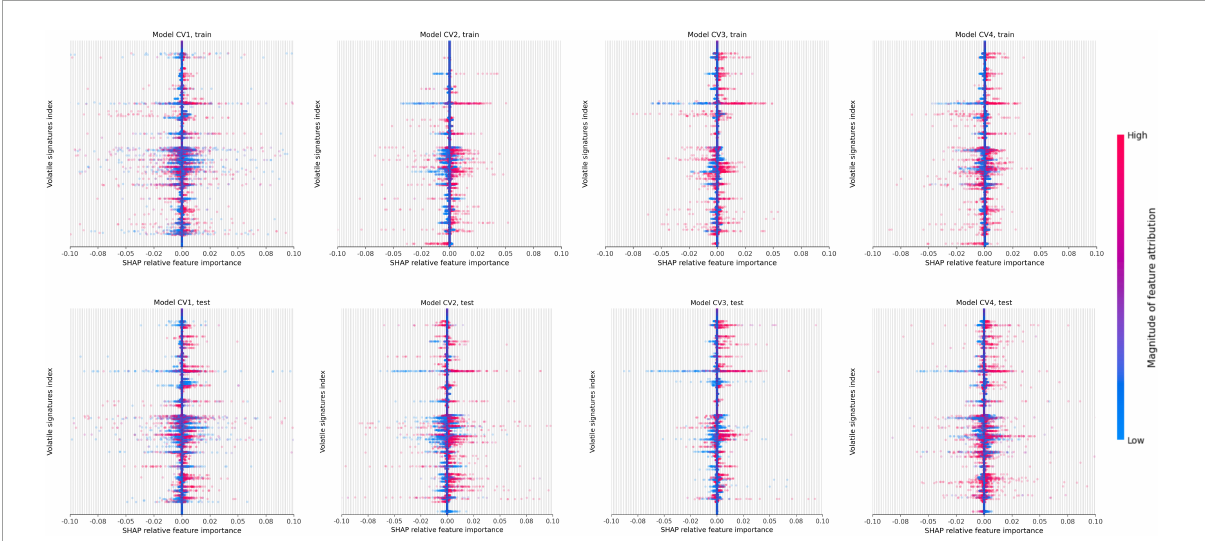
FIGURE6 Beeswarm summary plots on train and test data. This plot combines feature importance and feature effects. Every feature (VOC) is represented as a row on the y -axis (3,400 total) and SHAP values are on the x -axis (multiple VOC may overlap at a single index). Each dot represents a Shapley value for a given sample prediction. The color intensity shows the magnitude of importance of each